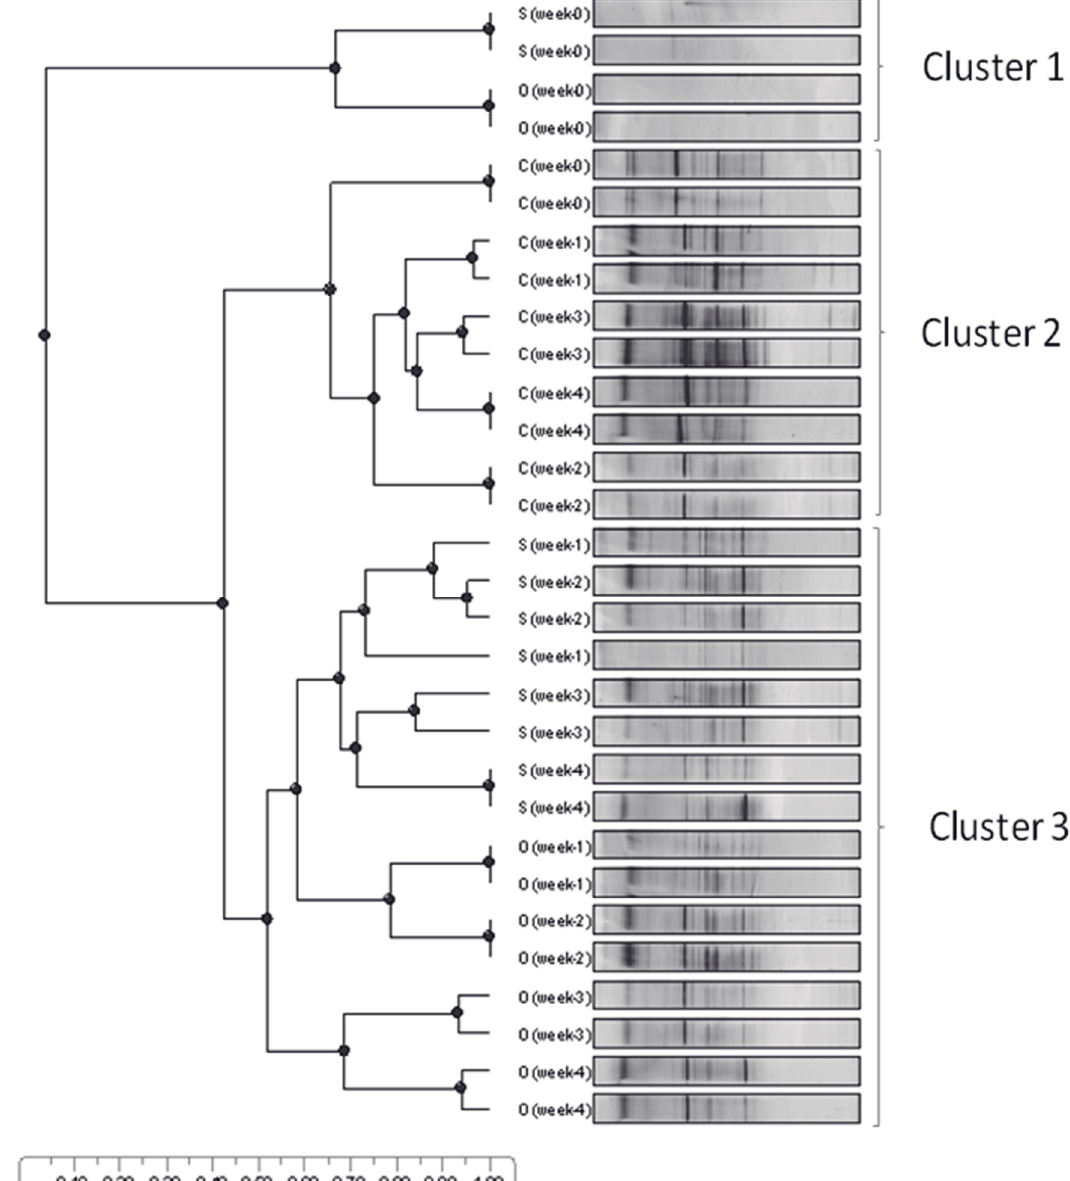
Figure 1. UPGMA dendrogram constructed from similarity matching data produced from the TGGE profiles of cDNA amplified from Week 0 to Week 4 of samples S (seawater + BH medium), O (seawater + BH medium + weathered crude oil), and C (seawater + BH medium + weathered crude oil + consortia). The scale bar represents percent similarity. Duplicate samples were